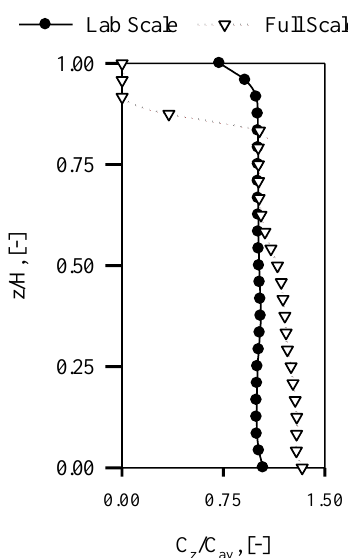
Figure 7. Axial concentration profiles for lab scale ( T = 0.288 m) and full scale ( T = 10 m) stirred tanks with C = T /6 and D i = T /3.